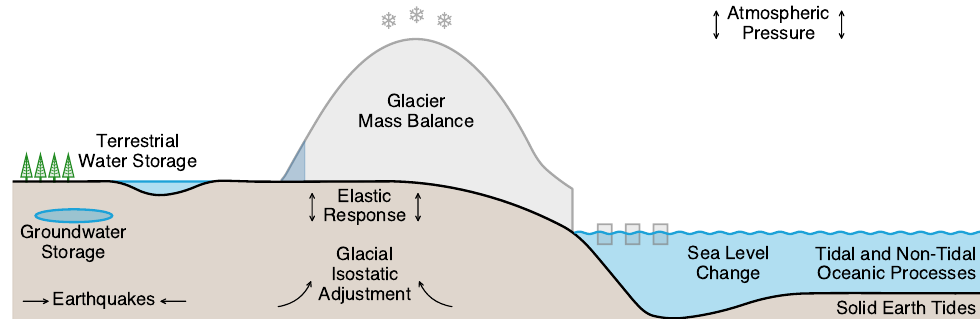
Figure 1. Schematic of the major geophysical processes contributing to mass variability sensed by time-variable